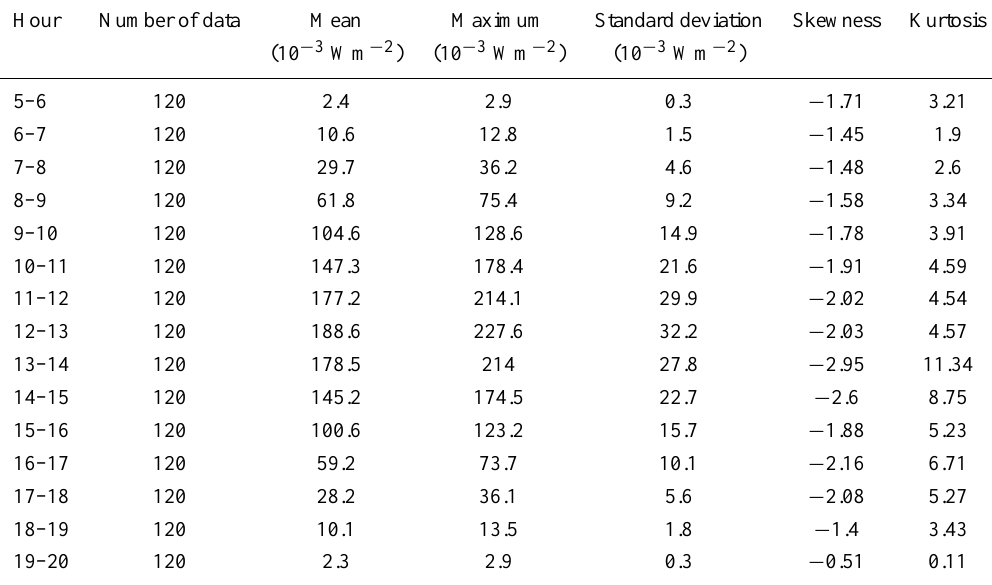
Table 4. Statistical parameters of hourly mean ultraviolet erythemal irradiation for June. Hour Number of data Mean Maximum Standard deviation Skewness